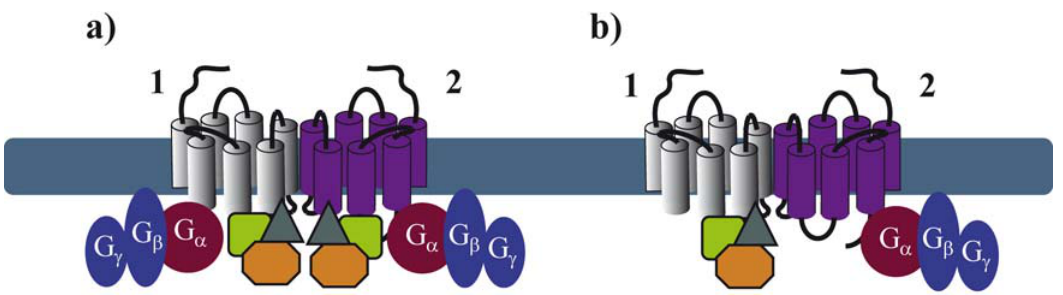
Figure 4. Symmetry (a) and asymmetry (b) of GIP and G protein coupling within a GPCR